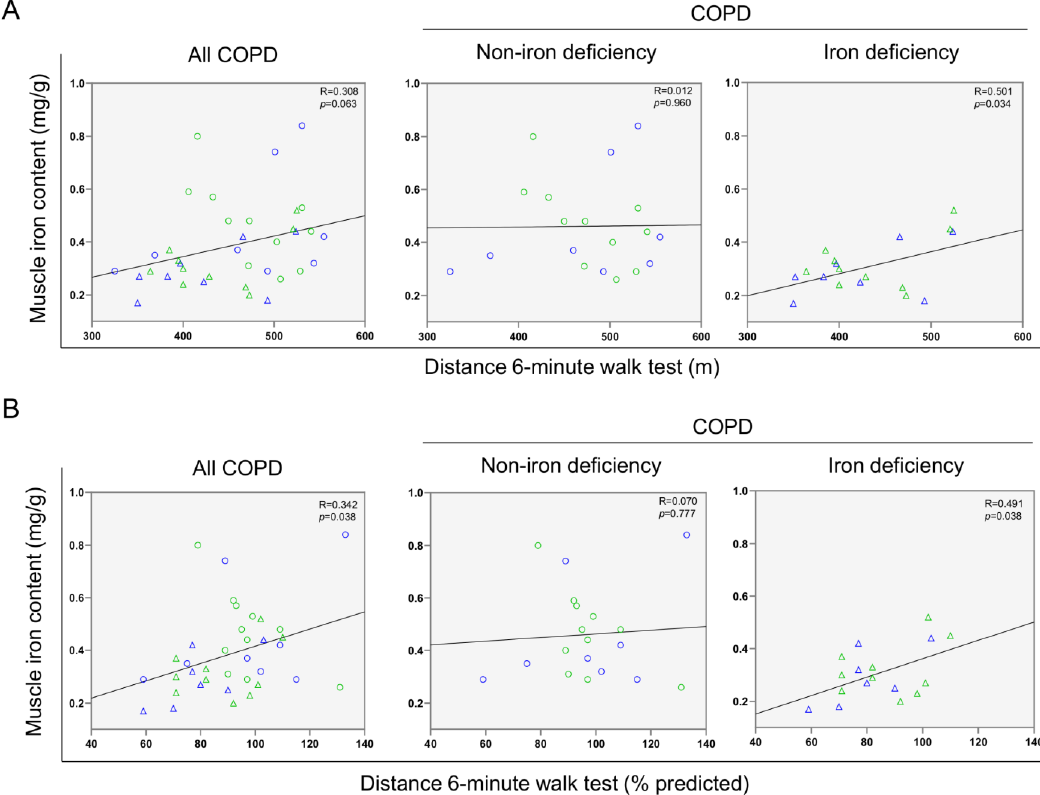
Figure 6. Scatter plots representation of correlations between muscle iron content and distance six-minute walk test (m) ( A ) and distance six-minute walk test (% predicted) ( B ) in all COPD patients ( left panels), non-iron deficiency ( middle panels) and iron deficiency ( right panels) COPD patients. In the scatter plots, the green color dots or triangles indicate male patients in either study group, while the blue color dots or triangles indicate female patients in the same groups. Definition of ab- breviations: COPD, chronic obstructive pulmonary disease.